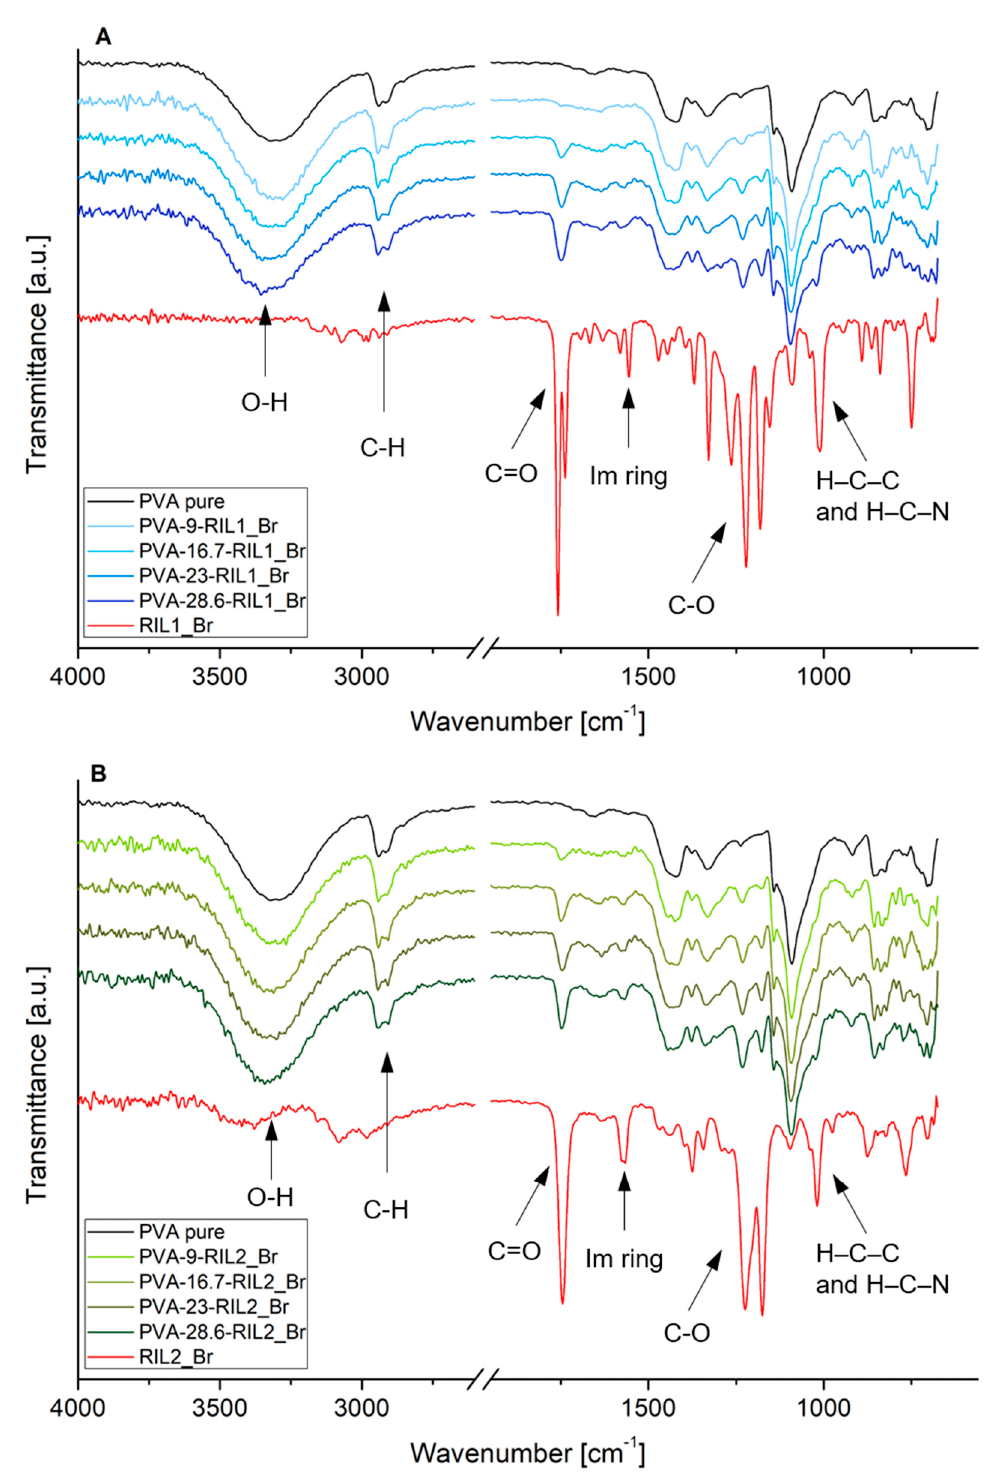
Figure 4. FTIR-ATR spectra of pure PVA, pure RILs and PVA-based RIL films with ( A ) RIL1_Br and ( B ) RIL2_Br at various ionic liquid content.